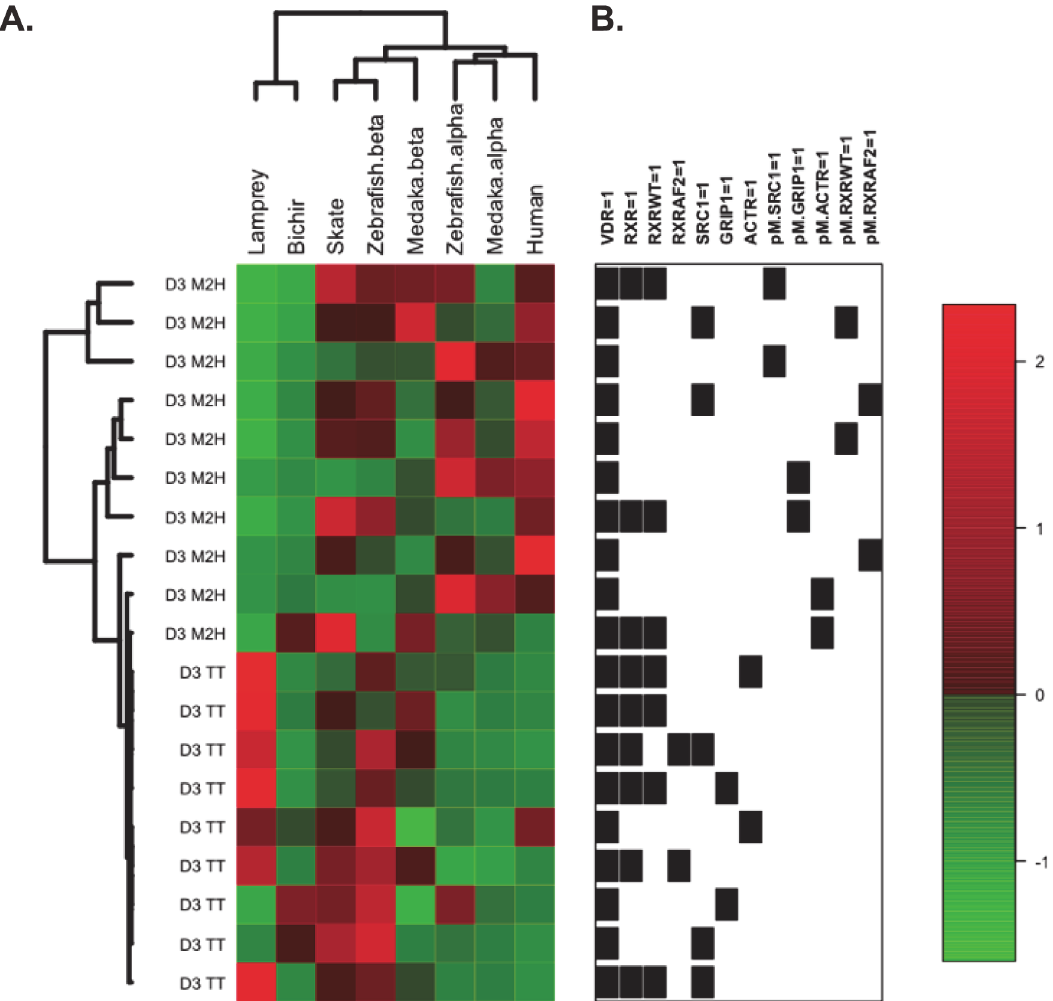
Fig 9. Hierarchical clustering of transient transactivation (TT) and mammalian 2-hybrid (M2H) assays. (A) Clustering includes eight VDR orthologs with Manhattan distance and complete linkage. Data for each assay (rows) were standardized as z-scores across all eight VDR species (columns) to account for interspecies differences in absolute assay readout. (B) The Pickett Plot to the right of the heatmap indicates the presence/absence of coregulators within each